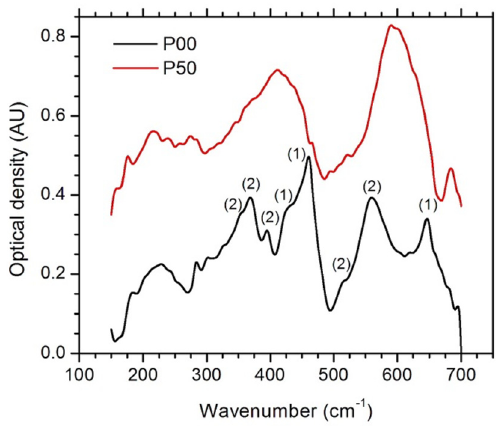
Figure 3. Optical density of polycrystalline CaMnO 3 − δ and Pr 0.5 Ca 0.5 MnO 3 . The indices (1) and (2) indicate the bands corresponding to the vibrations of apical and in-plane oxygens, respectively.